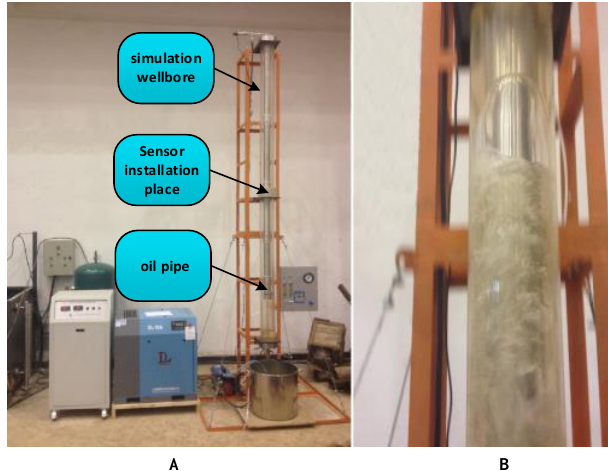
Figure 8. Two-phase flow simulator. ( A ) The two-phase flow simulator; ( B ) The slug flow.